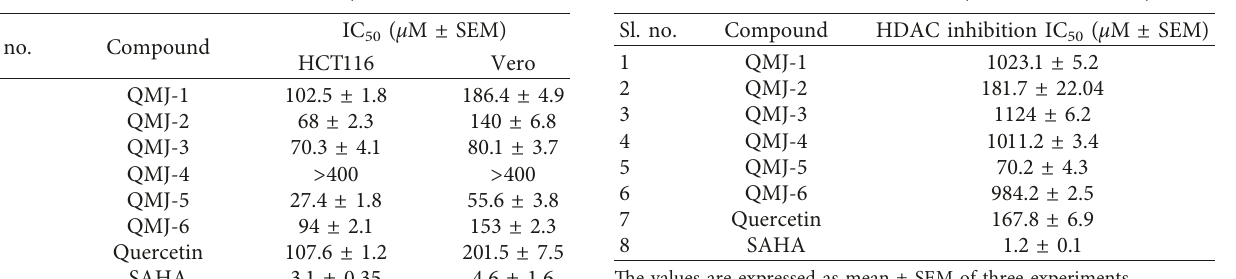
Table 1: MTT assay. Table 2: Whole cell HDAC enzyme inhibition assay.